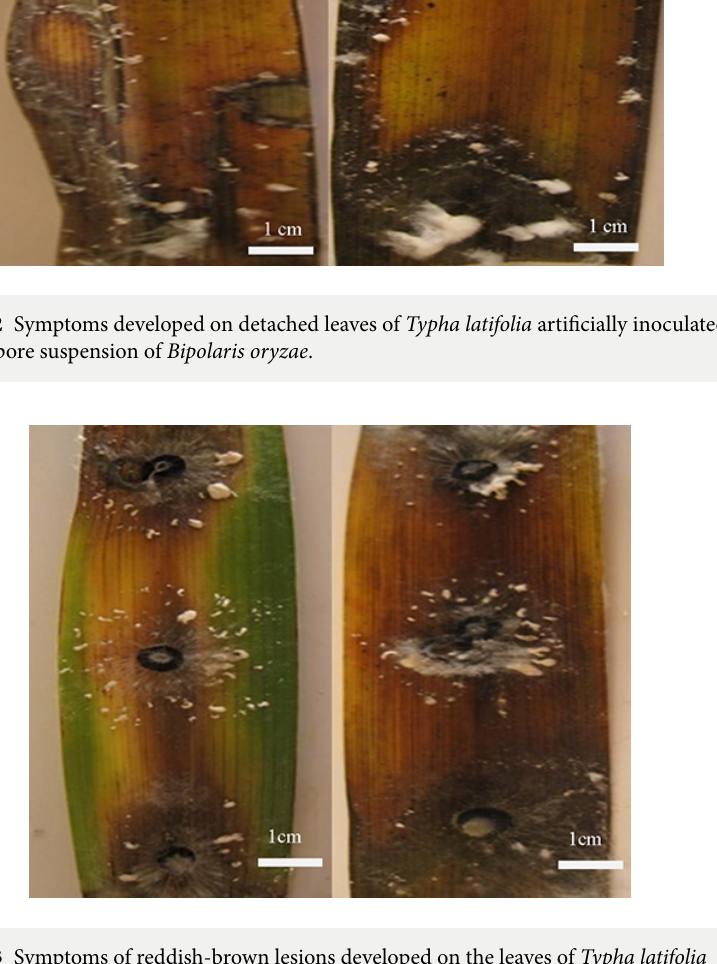
Figure 3 Symptoms of reddish-brown lesions developed on the leaves of Typha latifolia artificially inoculated with mycelial discs of Bipolaris oryzae .